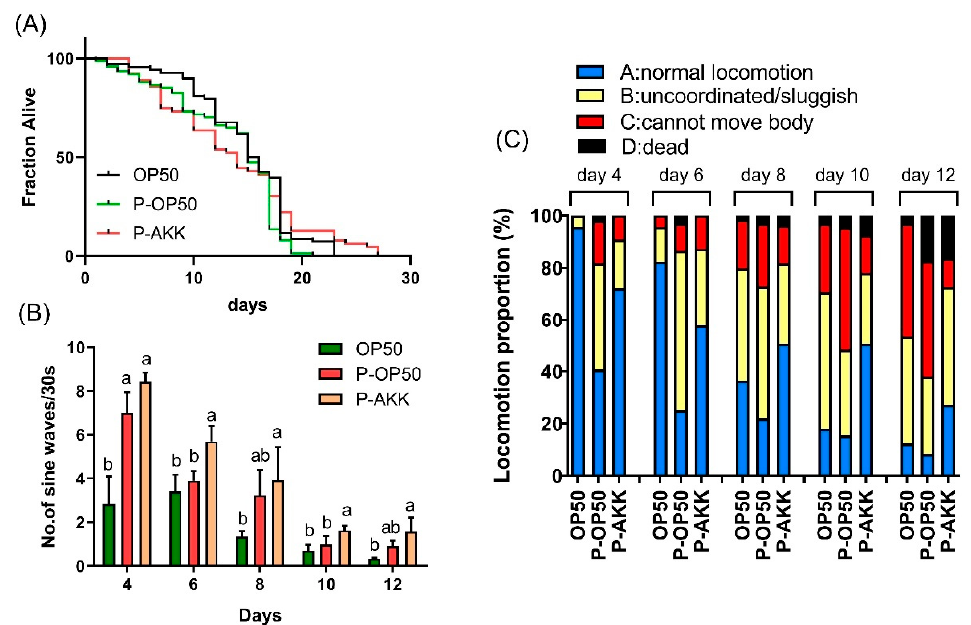
Table 1. Lifespans of nematodes treated with different types of bacteria.